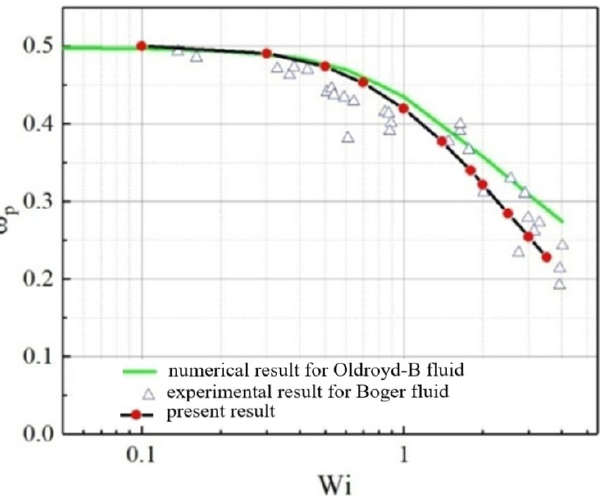
Figure 3. Comparison of particle angular velocity for different values of Wi.